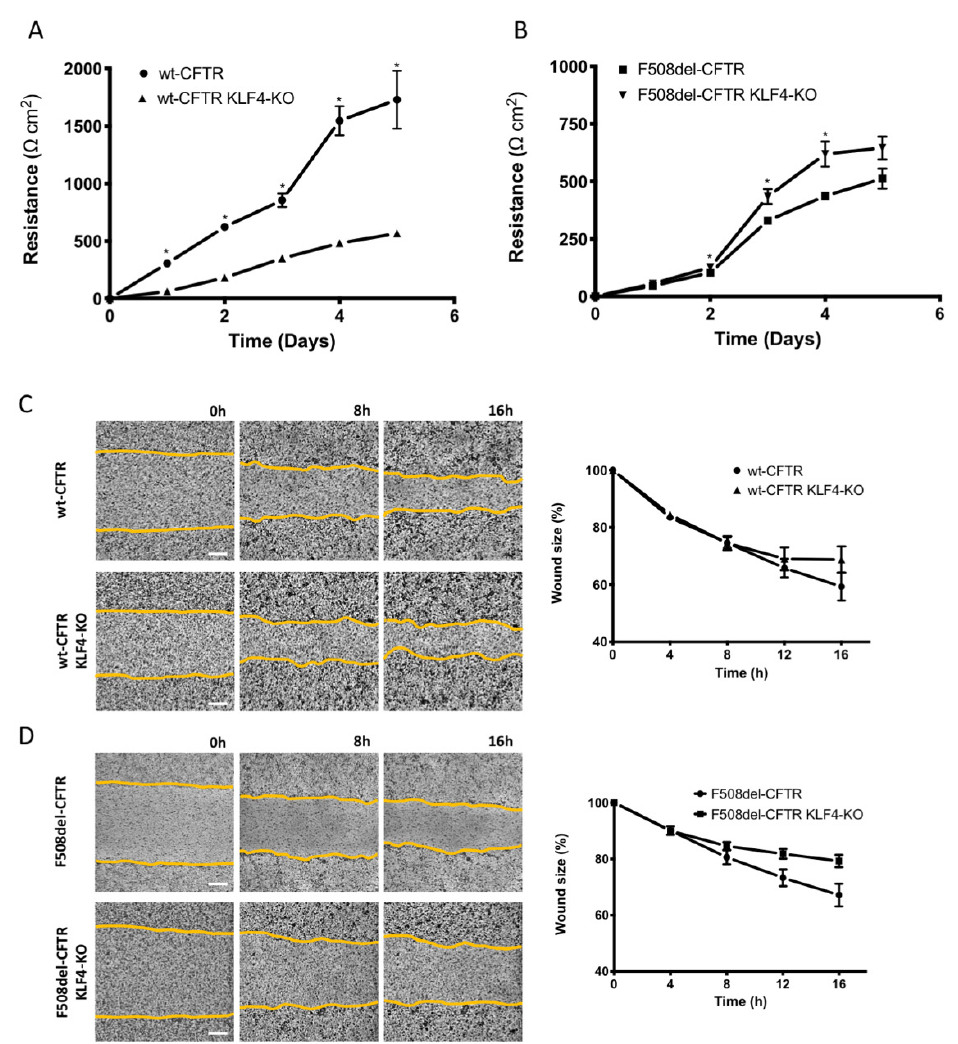
Figure 2. Impact of KLF4 KO on transepithelial electrical resistance (TEER) and wound healing. ( A ) TEER in wt- and ( B ) F508del-CFTR CFBE cells and their KLF4 KO counterparts over time. ( n = 3, unpaired t -test, * is p < 0.05) ( C ) Representative images of wound healing over time (0, 8, and 16 h) on polarized wt-CFTR and wt-CFTR KLF4 KO and ( D ) polarized F508del-CFTR and F508del-CFTR KLF4 KO CFBE cells. Graphs (right panels) are showing the analysis of wound closure (wound size in %) over time (h). Data were normalized to the initial area of the wound and is represented as a percentage. Scale bar represents 300 μ m. ( n = 5).